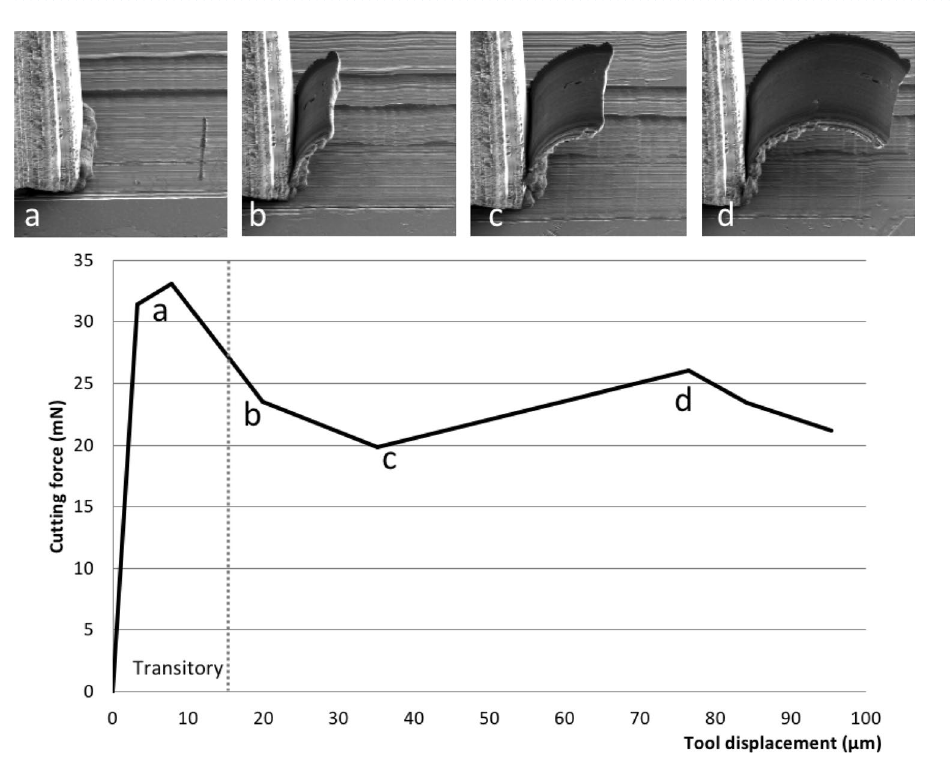
Figure 4. Representation of cutting force vs. cutting